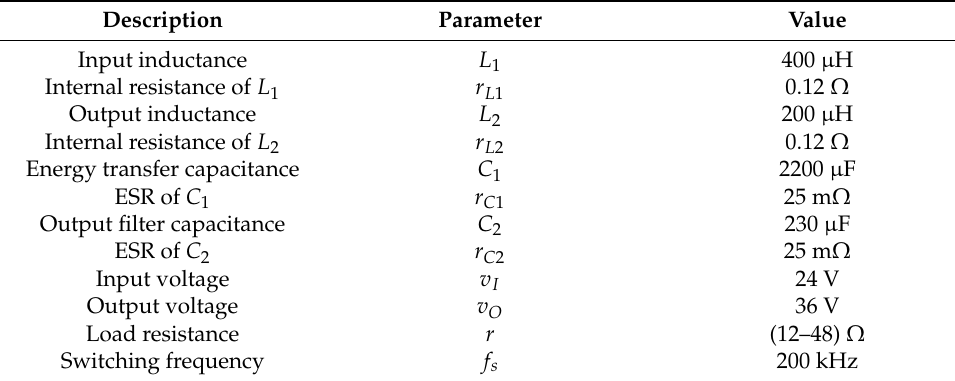
Table 2. The parameters of the DC-DC Cuk converter.